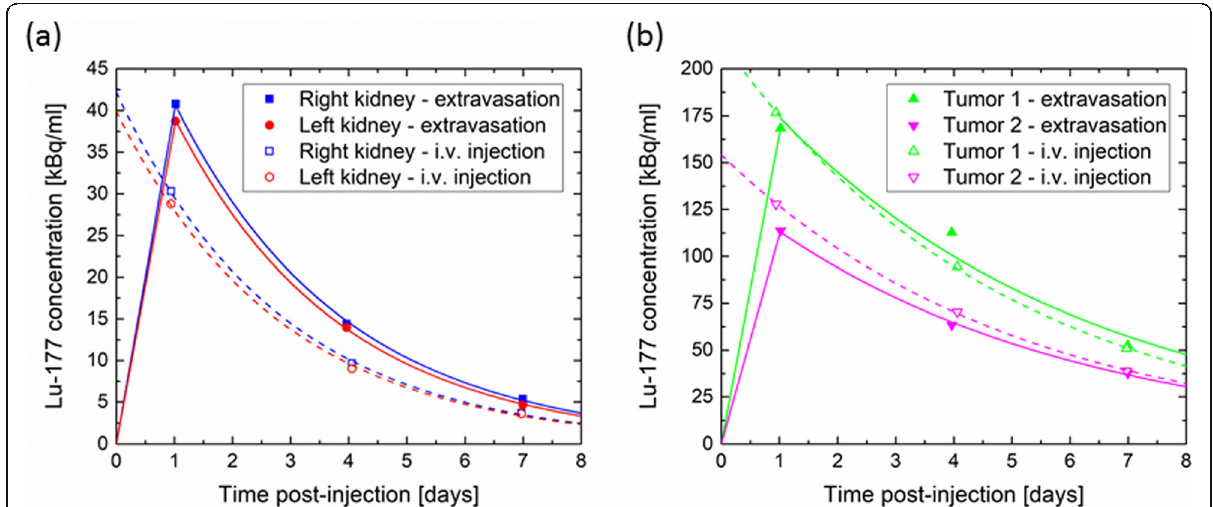
Fig. 4 Mean activity concentration in ( a ) the left and right kidneys and ( b ) two tumors in the liver after the first and second PRRT cycle. The areas under the solid and dashed curves are proportional to the absorbed doses given in Table